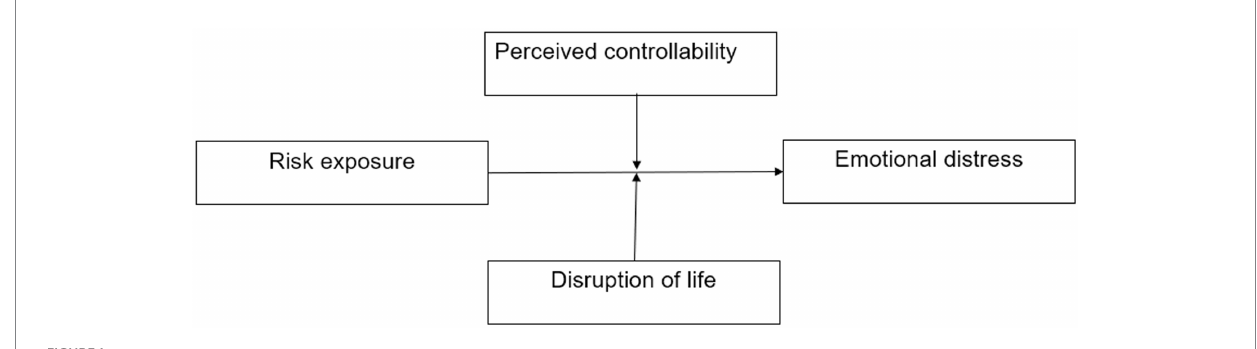
FIGURE 1 The analytical framework of risk exposure affecting emotional